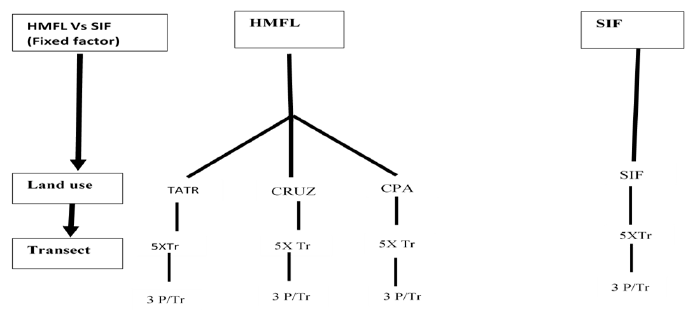
Figure 3. Schematic diagram of the sampling design to compare the overall species richness and the local contribution to β -diversity of Human Modified Forest Landscape (HMFLs) against SIF (HMFL vs. SIF) for the second hypothesis.